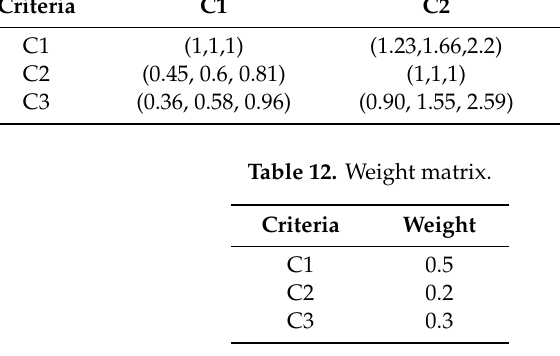
Figure 12. The optimal biorefinery configuration of the optimal point S3 for profit and toxicity damage index in Figure 8b.